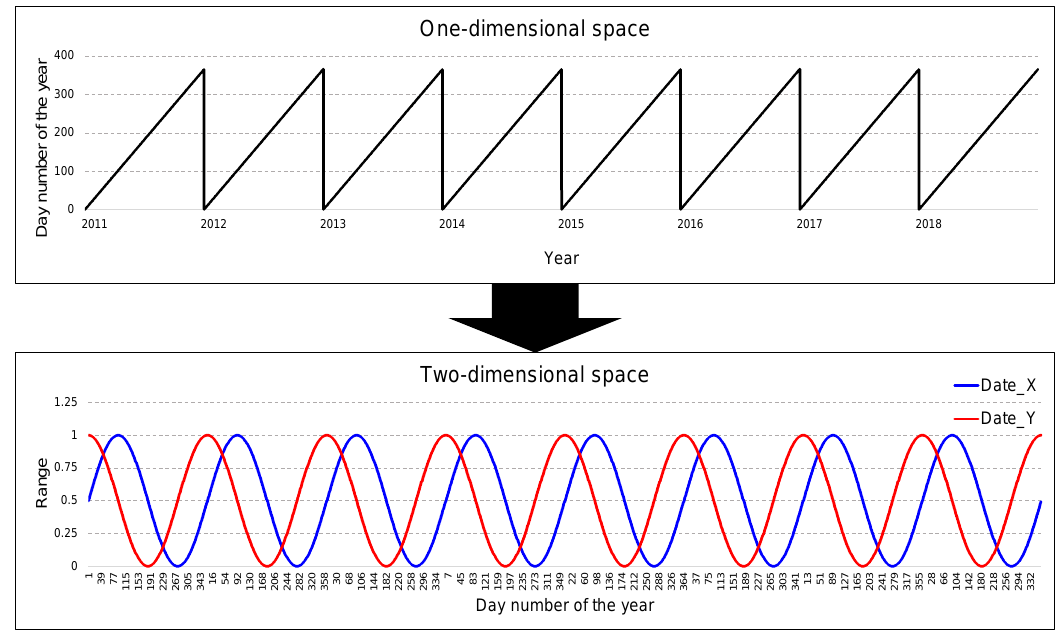
Figure 2. Example of date data preprocessing.